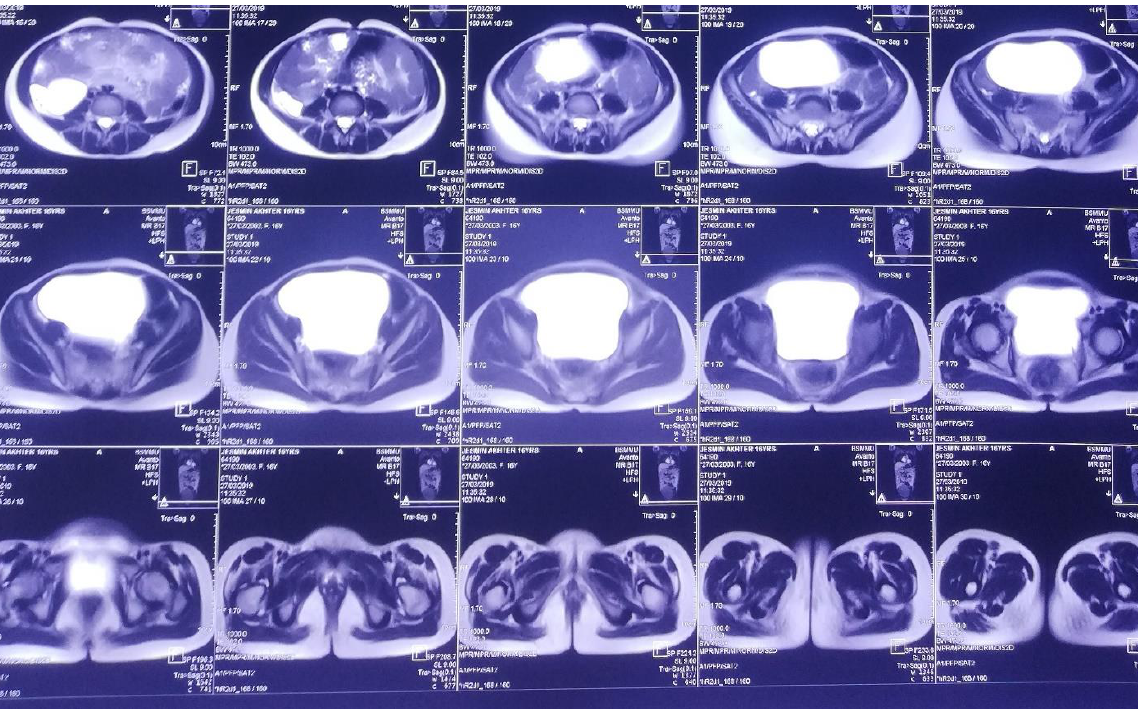
Figure – 4, MRI of abdomen is showing the absence of adnexa, uterus and upper part of the vagina with horseshoe kidney as well as right sided gross